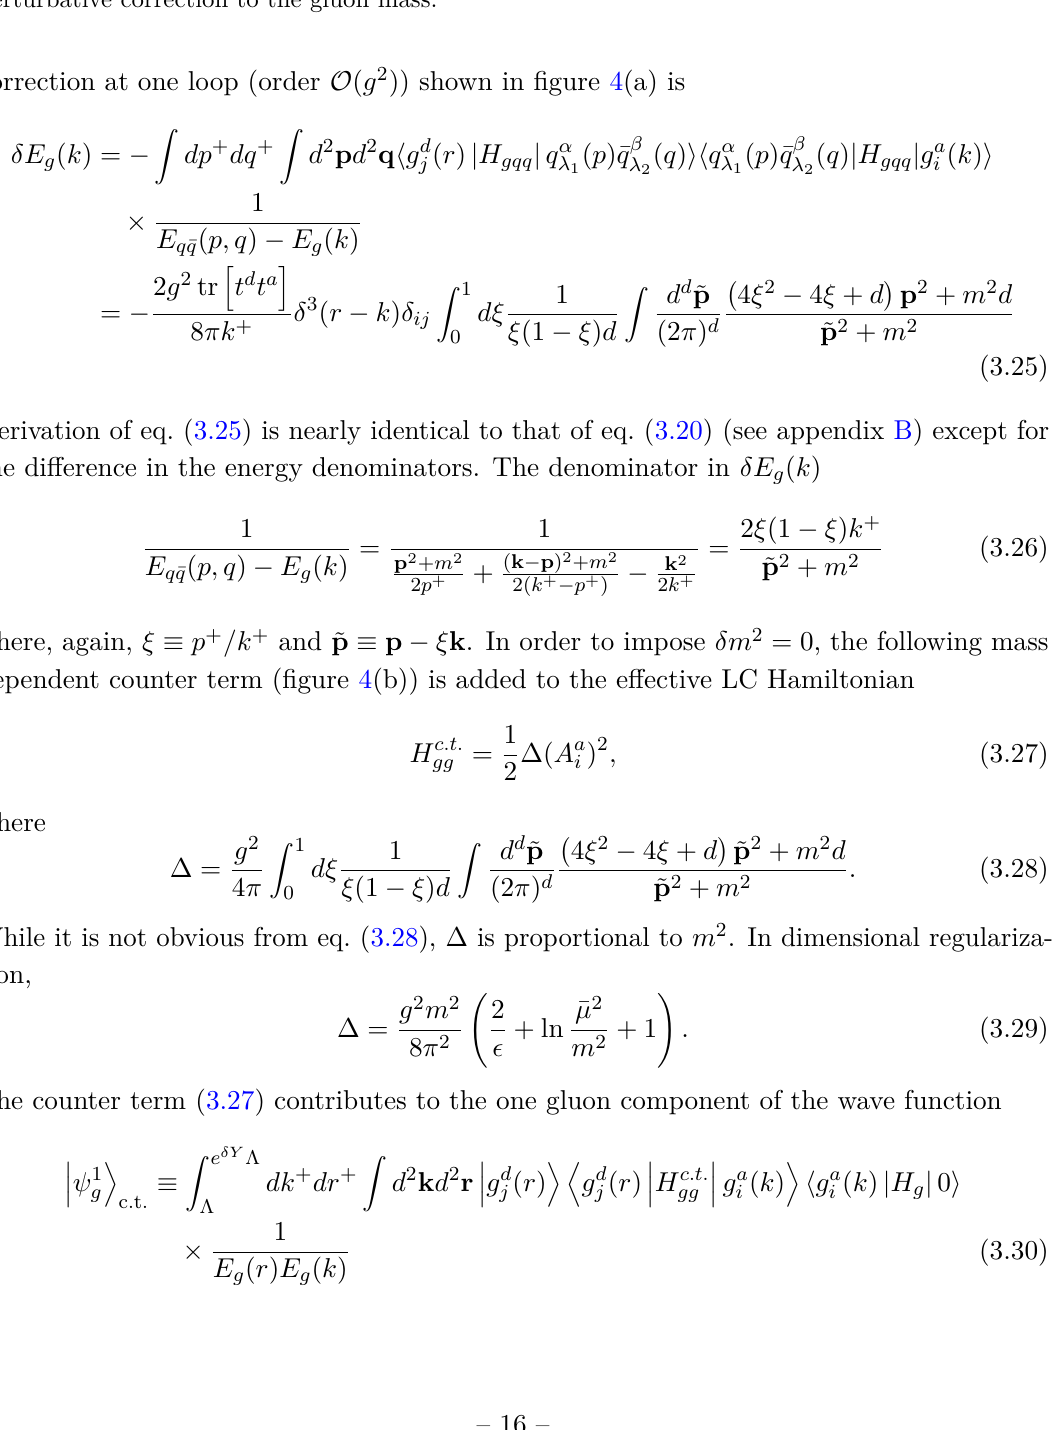
Figure 4 . Self energy diagram (a) and the counter term (b) needed to ensure vanishing of the perturbative correction to the gluon